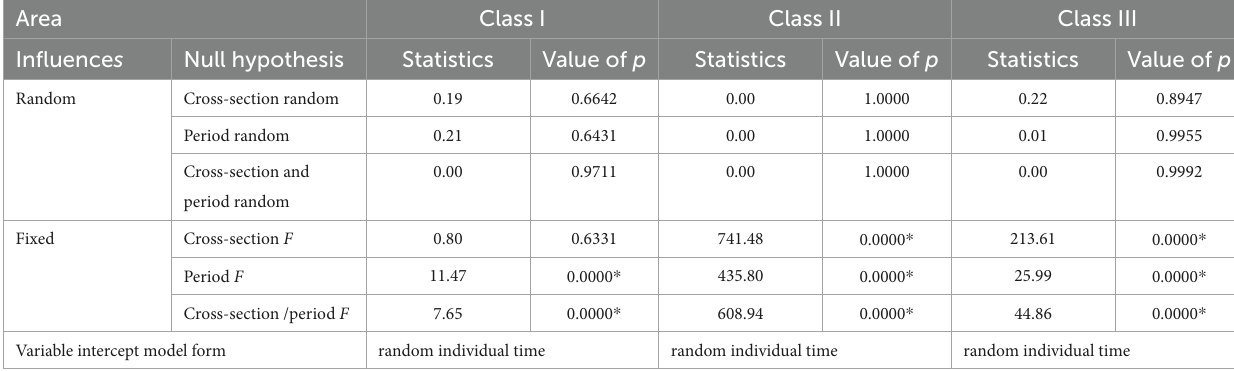
Variable intercept model form random individual time random individual time random individual time “ * ” indicates the difference of root test results, and the more * , the greater the difference.